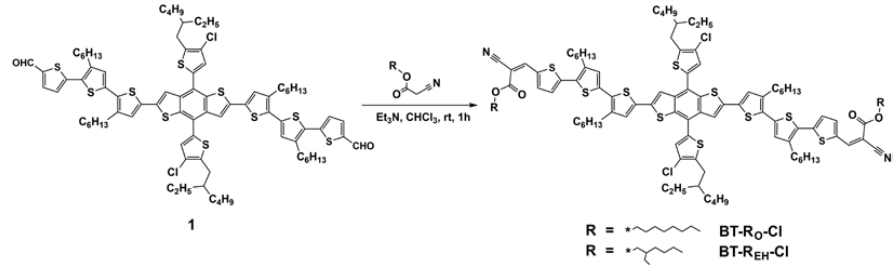
Figure 1. The synthetic route of BT-R O -Cl and BT-R EH -Cl. Synthesis of BT-R O -Cl: Compound 1 (0.1442 g, 0.0940 mmol) dissolved in dry chlo-